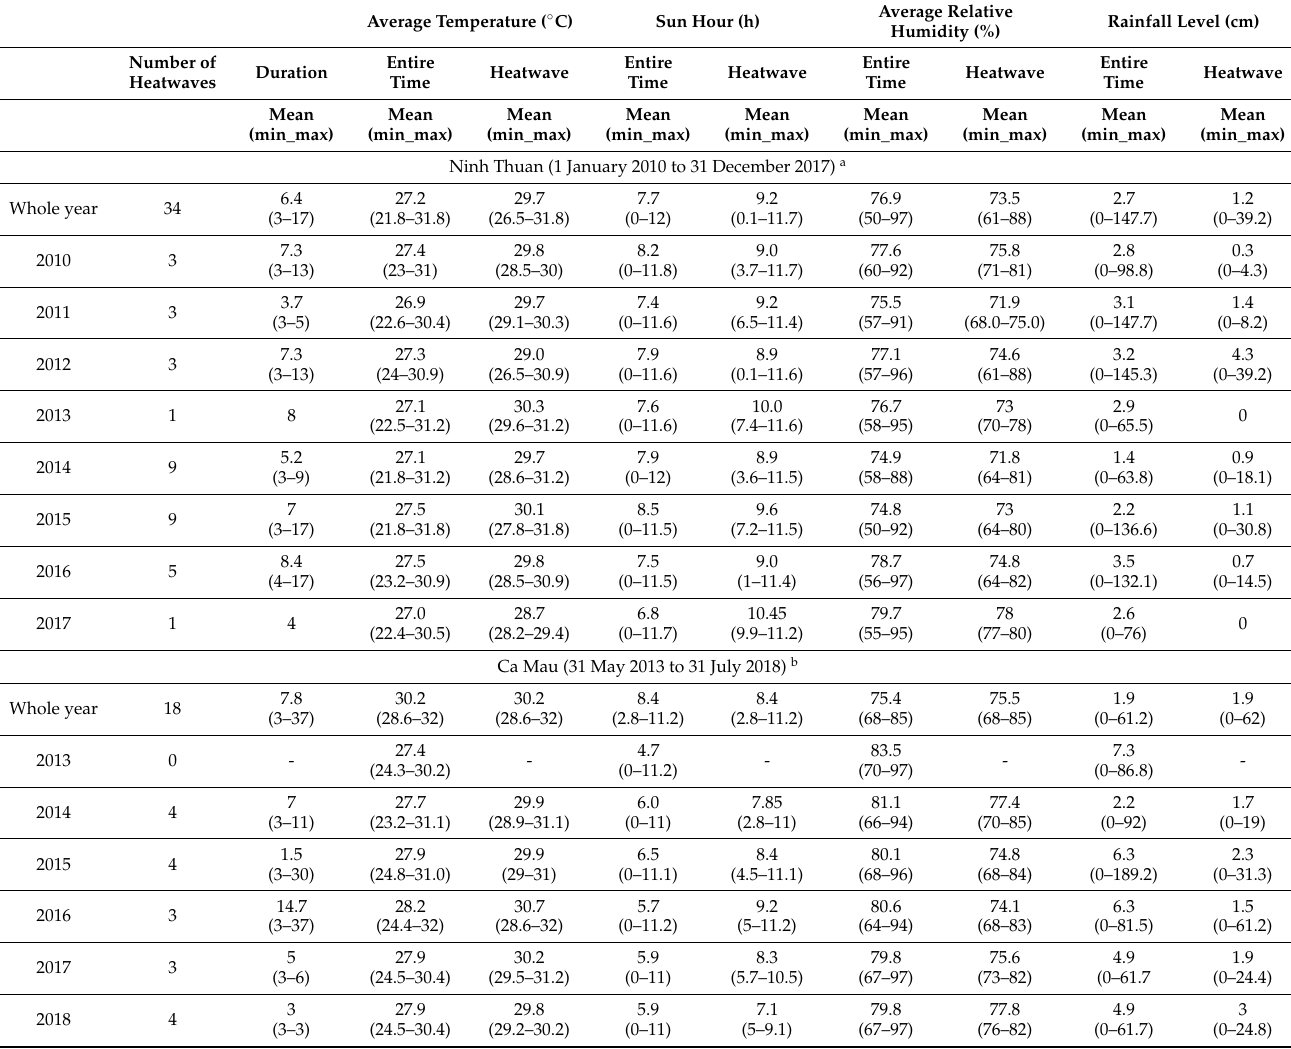
Table 2. Hospital admissions for respiratory and cardiovascular diseases in Ninh Thuan and Ca Mau in total and by age group in whole studied periods and periods during heatwaves